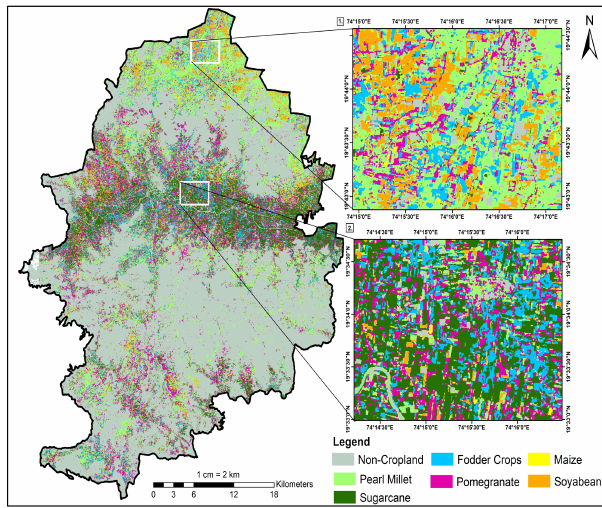
Figure 4. Crop type map (10m) obtained using RF classification. Inset 1 shows the crops of rainfed and inserts 2